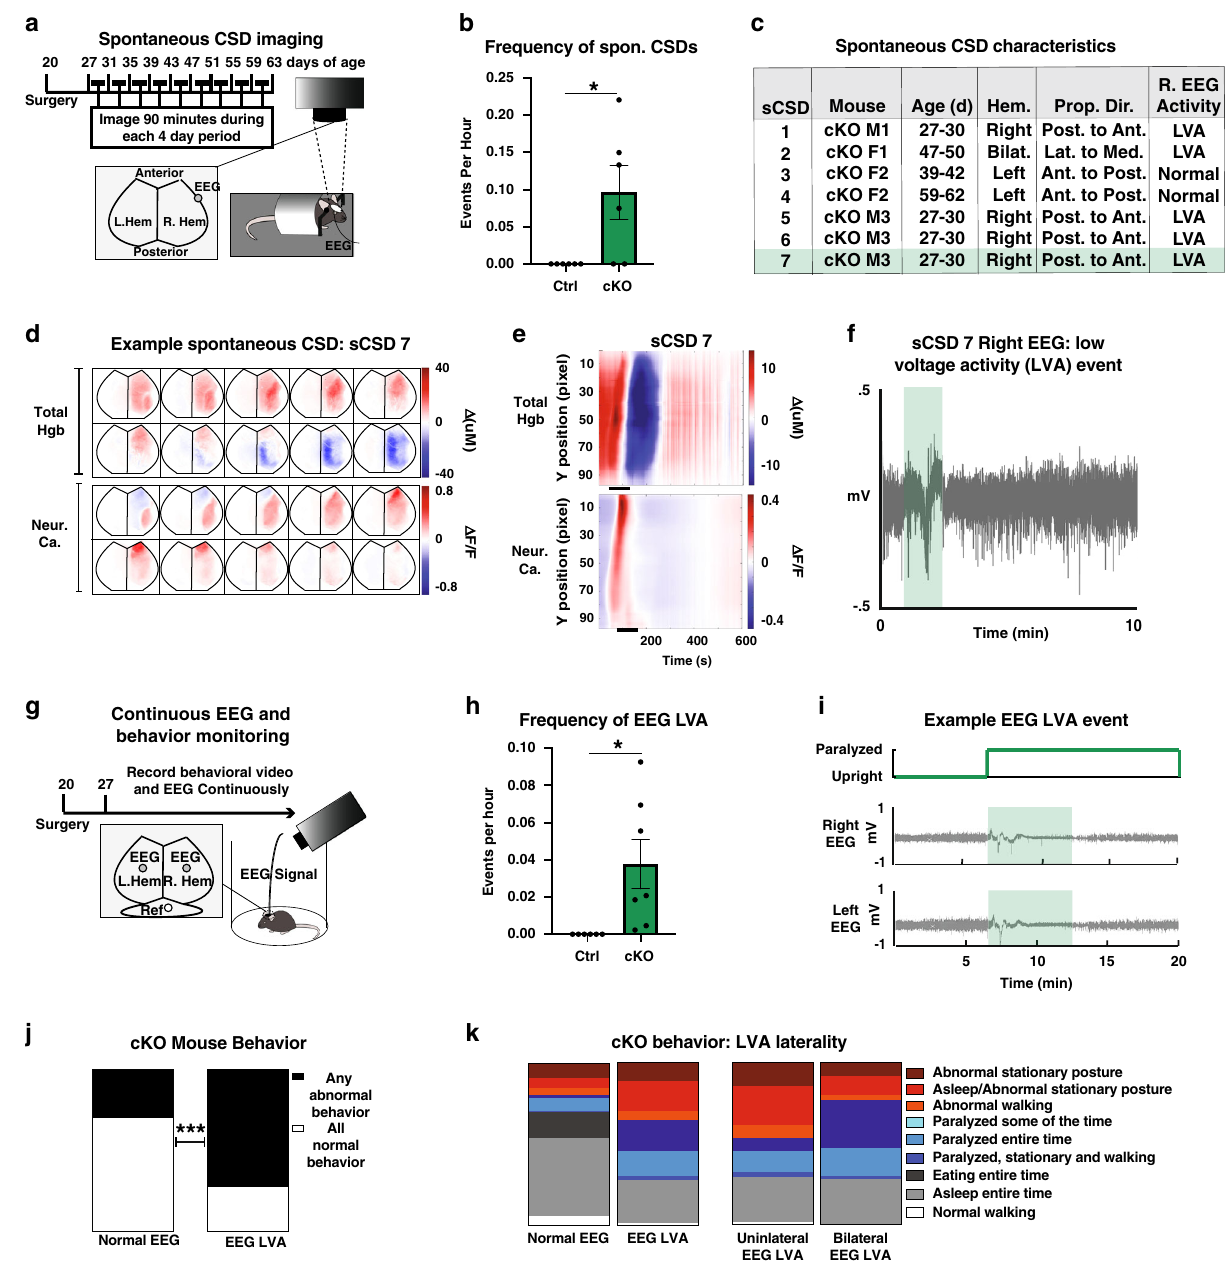
Fig. 3 Spontaneous cortical spreading depression in conditional α 2-Na/K ATPase knockout mice correlates with transient motor paralysis. a – h Conditional α 2-Na/K ATPase knockout mice (cKO) and Ctrl mice were monitored for spontaneous cortical spreading depression (sCSD) events in intrinsic optical signal imaging for total hemoglobin, with GCaMP6f imaging for neuronal calcium in a subset, and right hemispheric EEG recording ( n = 6 Ctrl, 6 cKO mice, 3 male and 3 female, 81 Ctrl and 75 cKO hours). Frequency of sCSD events in cKO and Ctrl mice ( b ). No sCSD events were observed in Ctrl mice. Data are presented as mean ± s.e.m. * P < 0.05 (two-tailed t test, n = 6 mice per group, P < 0.0001). Table of all observed sCSD events ( c ). LVA low-voltage activity. Green box indicates pictured sCSD7 ( d – f ). The position-time plots for example sCSD in d with propagation of signal over time is shown in e . The shaded box on f corresponds to the time captured by the still images ( d ) and the black bar ( e , total time = 90 s, start at 50 s, 10 s between images). g – k cKO and Ctrl mice were monitored for low-voltage activity (LVA) events with continuous bilateral EEG and video monitoring. Frequency of observed LVA events in conditional cKO and Ctrl mice ( h ). No LVA events were observed in Ctrl mice. Data are presented as mean ± s.e.m. * P < 0.05 (two- tailed t test, n = 6 Ctrl mice — 3 male, 3 female, 7 cKO — 5 male, 2 female, P < 0.0001). Frequency of LVA events in cKO mice ( h ) does not differ from frequency of sCSD events ( b , two-tailed t test, P = 0.1307). An example LVA event ( i ). Shaded box indicates LVA in right and left hemispheres, green trace indicates paralysis. LVA events in cKO mice correlated with abnormal motor behavior ( j ). Proportions of normal (eating, sleeping, and walking) and abnormal behavior (abnormal posture, abnormal walking, and paralysis) in cKO mice during normal EEG and LVA events. *** P < 0.001 (Chi-squared test, n = 130 events in seven mice each, P < 0.0001). Breakdown of behaviors during normal EEG and LVA, and unilateral vs. bilateral LVA (abnormal behavior = colors, normal behavior = grayscale, n = 130 events, 62 unilateral 68 bilateral, in seven mice) ( k